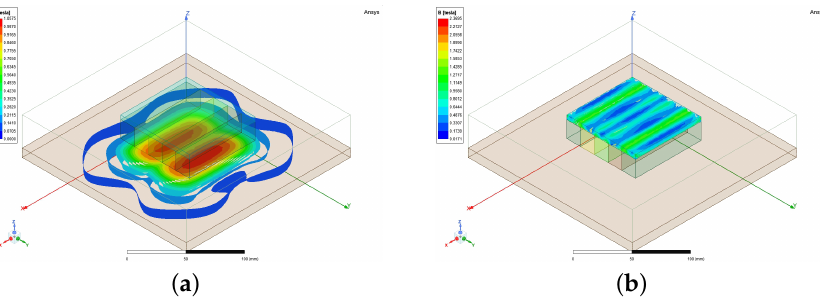
Figure 11. Simulation results for Halbach array magnetization. ( a ) Cloud map of the magnetic flux intensity on the test steel plate. ( b ) Cloud map of the magnetic flux intensity on the yoke.